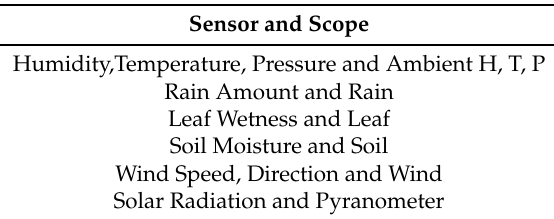
Table 1. The aggregated data by the IoT